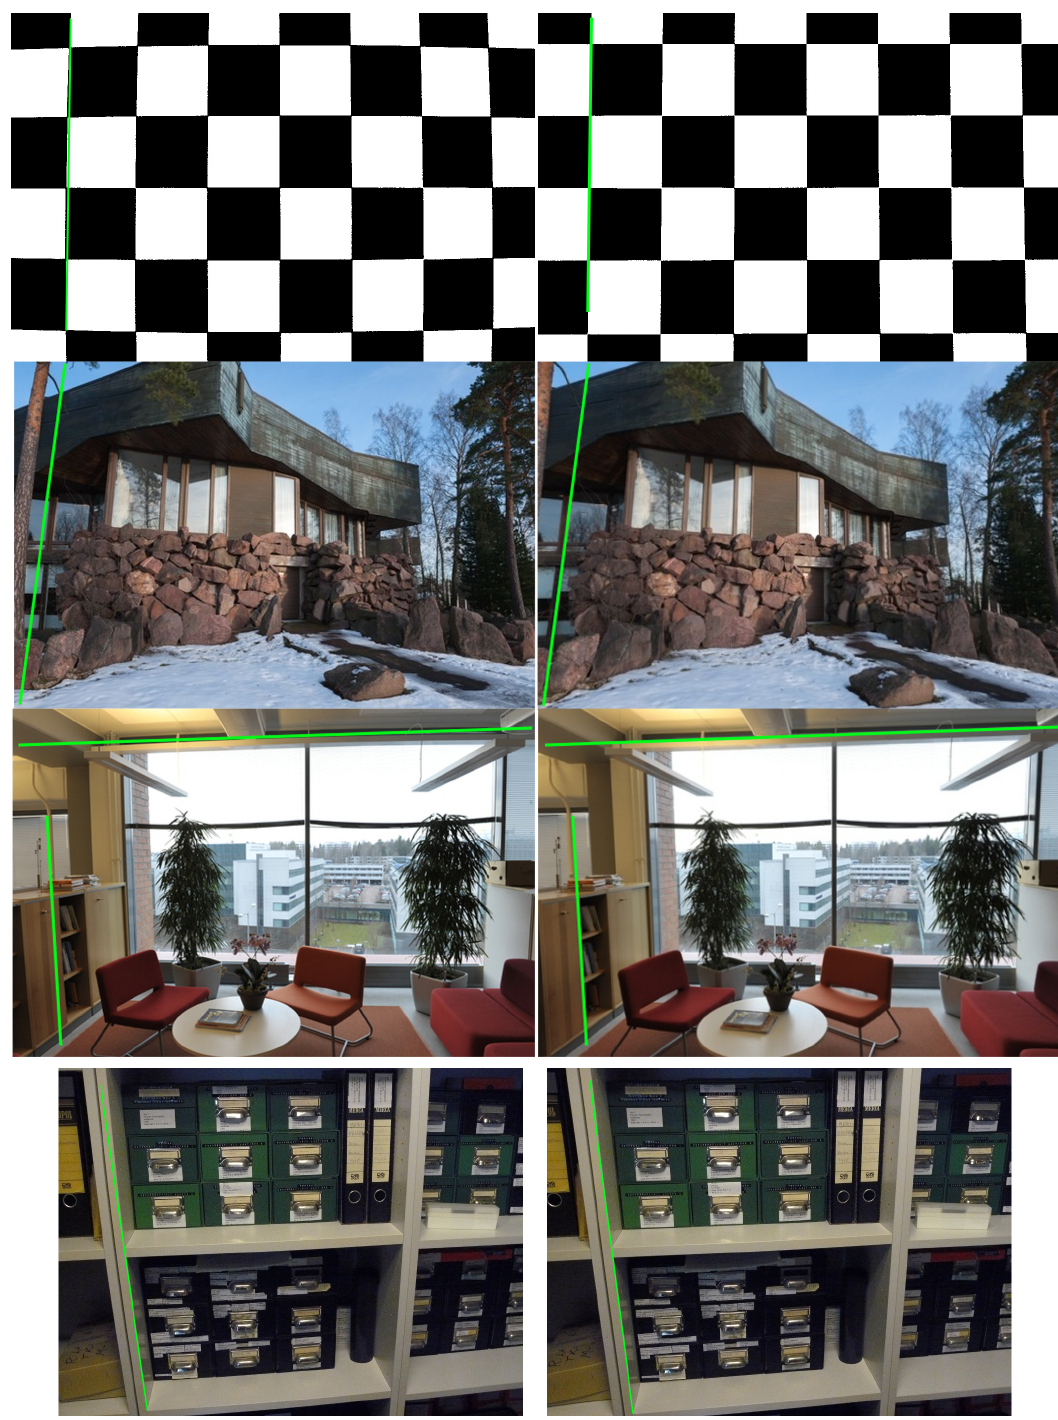
Figure 7. Results from EPOS. Distorted (left) and undistorted (right) images for D700 24 mm. The checkerboard image (top) is corrected using the converged value of η obtained from checkerboard data; see Figure 5. The image colors were simplified to black and white for visual reasons. Sample images of a building called Dipoli (second from top) and a sofa set (third from top) are corrected with values obtained from the respective sets. Bookshelf images taken with the Panasonic 6 mm lens are also corrected with the value obtained in situ. Dipoli set contains 11 photos, the sofa set 9 photos and the bookshelf set 5 photos. Real-world cases contain false matches and were chosen to be quite